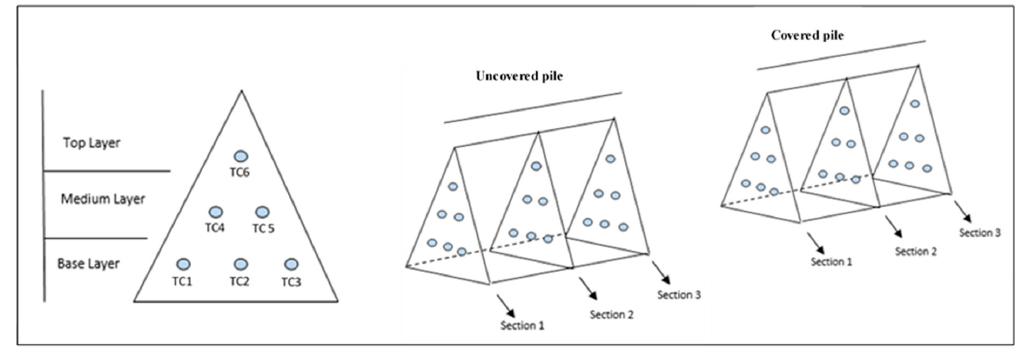
Figure 2. On the left side, the single transversal section of the scheme utilized to set the experiment; on the right side, the full scheme of the experiment with three sections (replicates) in both treatments.